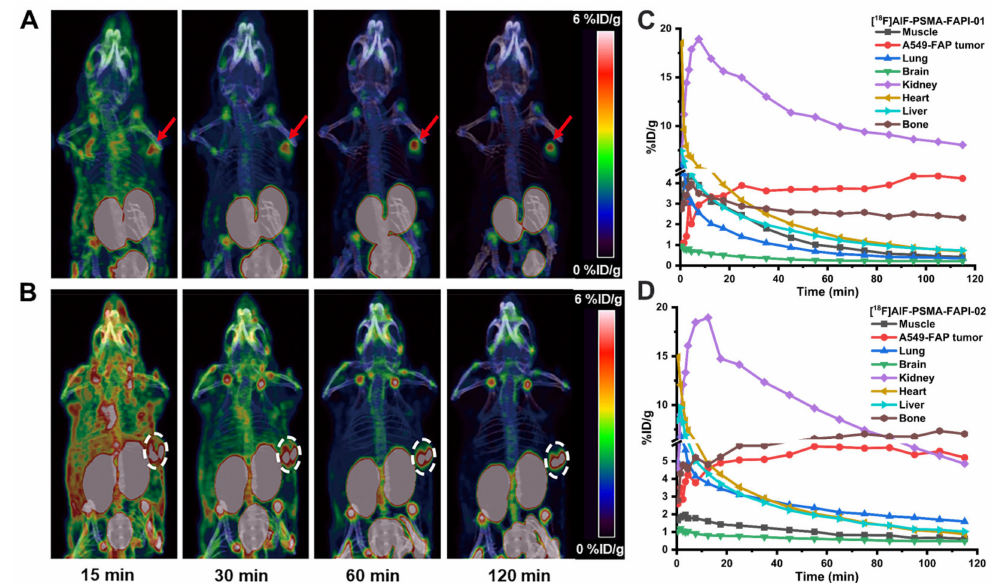
Figure 6. Maximum intensity projection (MIP) 15, 30, 60, and 120 min p.i. of [ 18 F]AlF-PSMA-FAPI-01 ( A ) and [ 18 F]AlF-PSMA-FAPI-02 ( B ) in A549-FAP tumor-bearing mice. Arrows and circles represent the locations of the A549-FAP tumors. Time-activity curves of [ 18 F]AlF-PSMA-FAPI-01 ( C ) and [ 18 F]AlF-PSMA-FAPI-02 ( D ) in selected organs up to 120 min